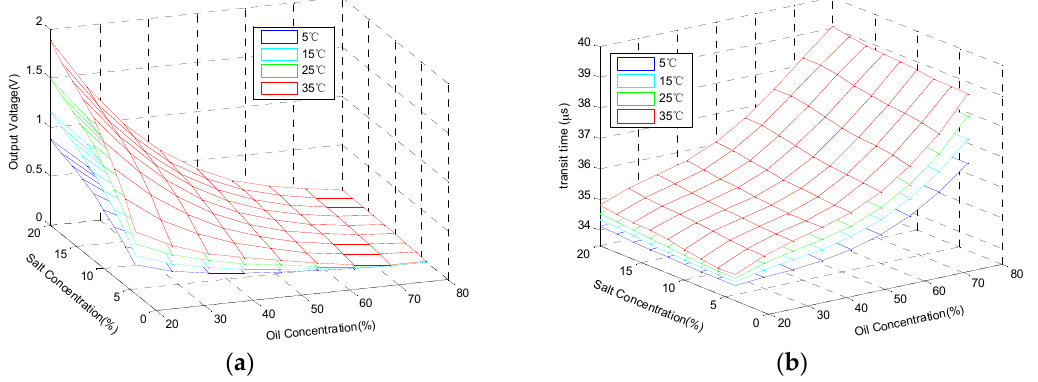
Figure 5. Experimental data: ( a ) Output voltage; and ( b ) Time of Flight.